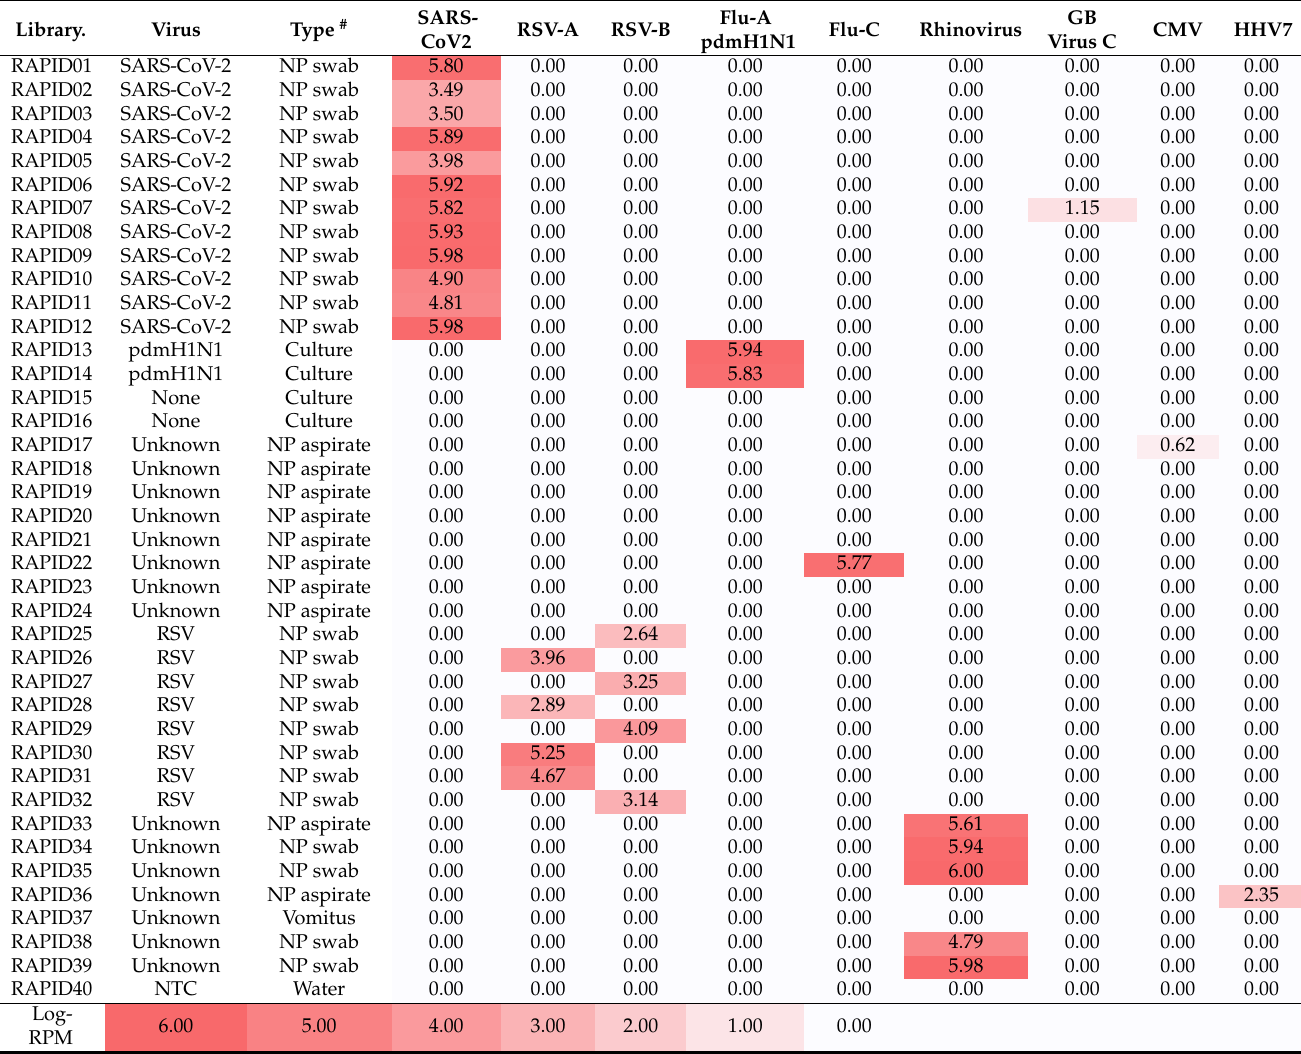
Table 4. Log-transformed reads per million ( log RPM) virus distribution across RAPID prep samples, with red shading indicating greater read depth as per the key provided at the bottom of the